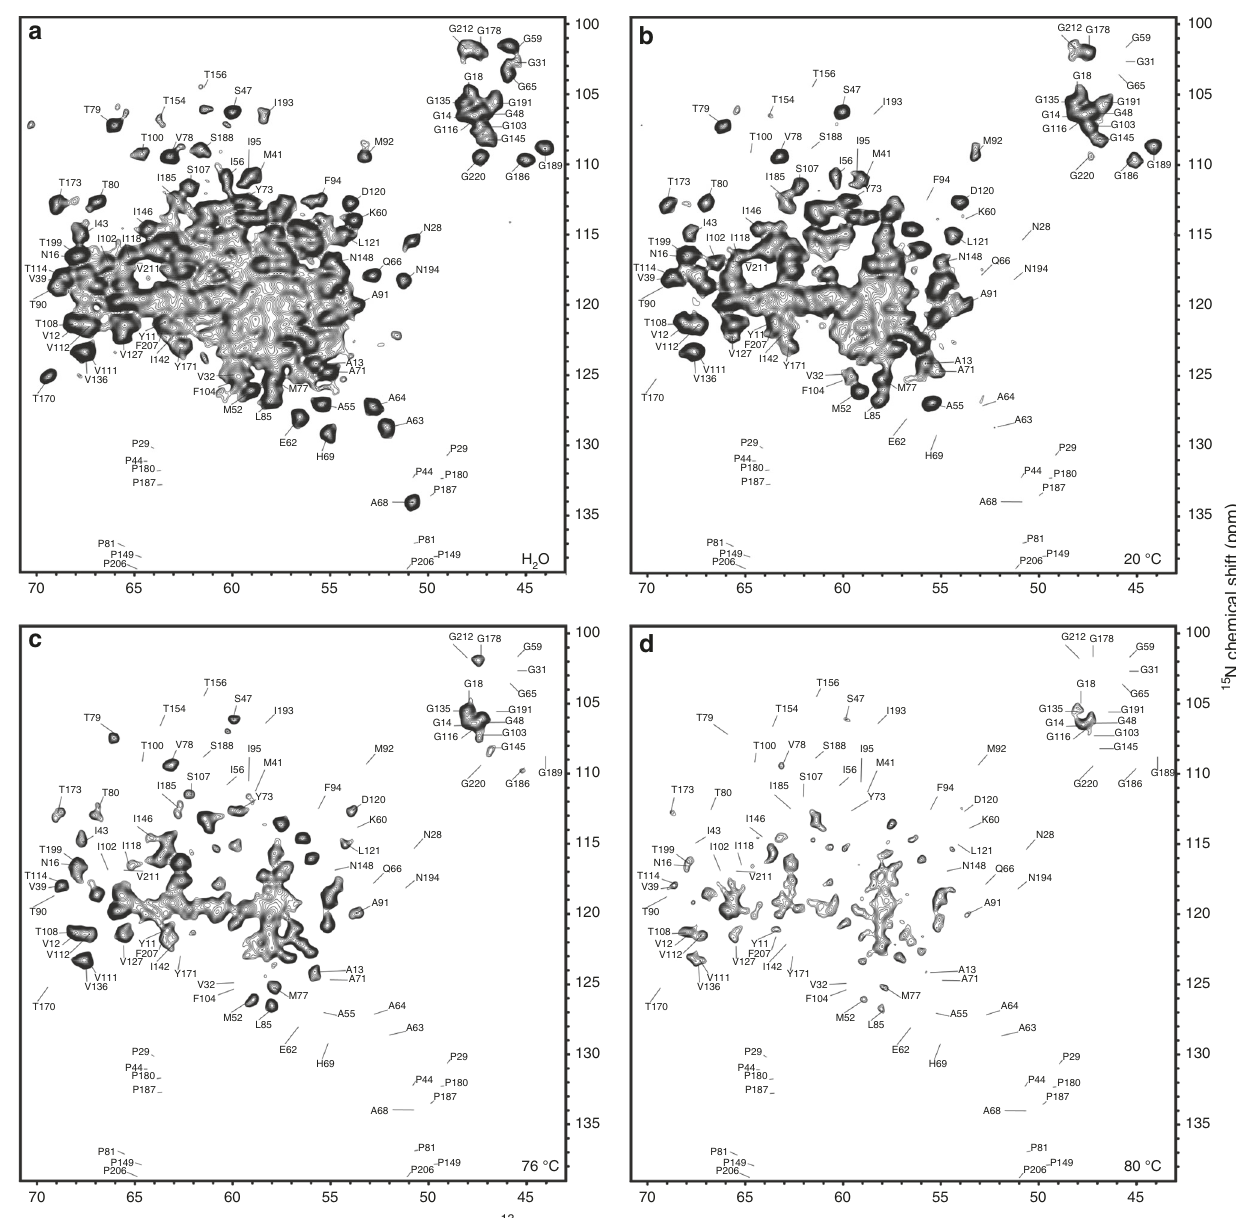
Fig. 2 2D NCA spectra of ASR as a function of incubation temperature. a Reference 2D NCA spectrum of ASR in H 2 O based buffer. b – d 2D NCA spectra collected after incubation in D 2 O at the indicated temperatures. Attenuated cross-peaks correspond to residues exposed to solvent due to unfolding. All spectra were collected on sample 1. The fi rst contour in all spectra is at 5 times root-mean-square of the